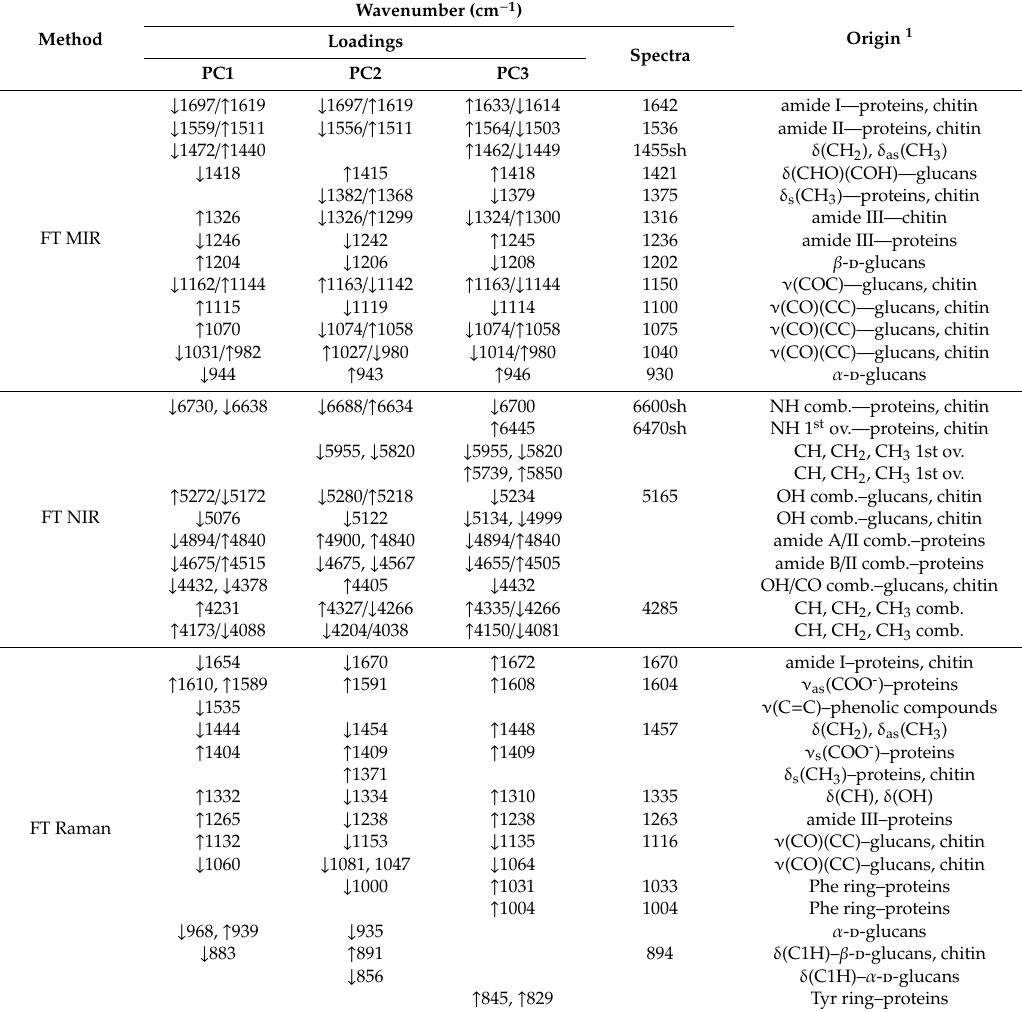
Table 5. Assignments of loading bands (cm − 1 ) for principal components (PC)